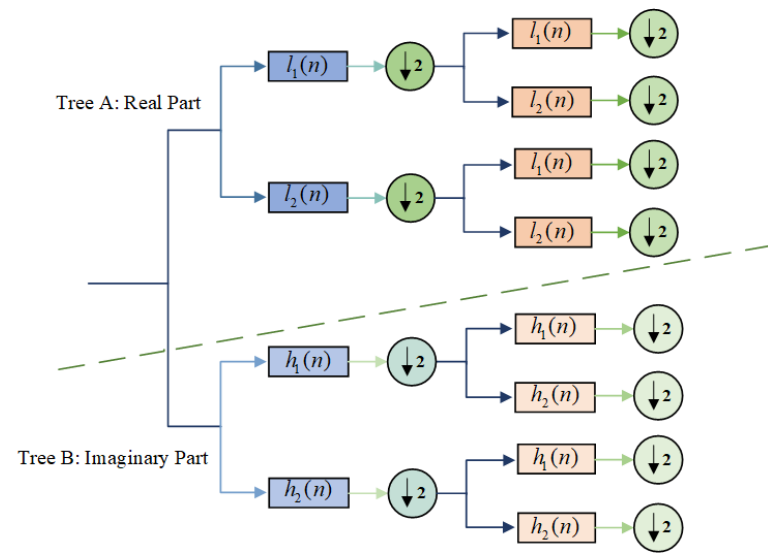
Figure 1. Decomposition structure of DTCWT.